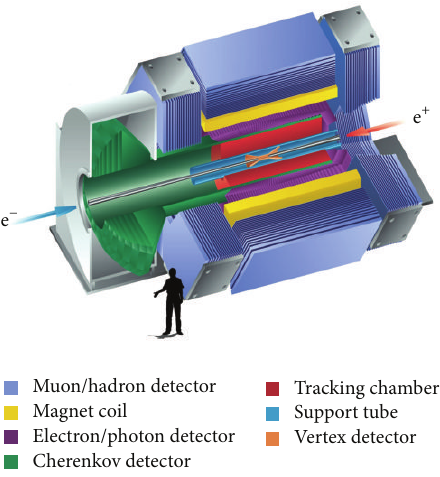
Figure 29: Schematic view of the BABAR experiment.